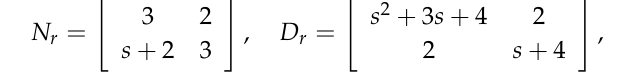
V 2 and norm of V T 1